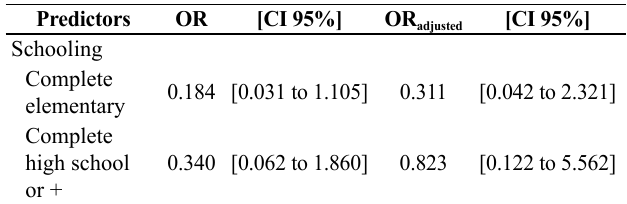
Table 3. Factors associated with the practice of systematized physical activity in the elderly.